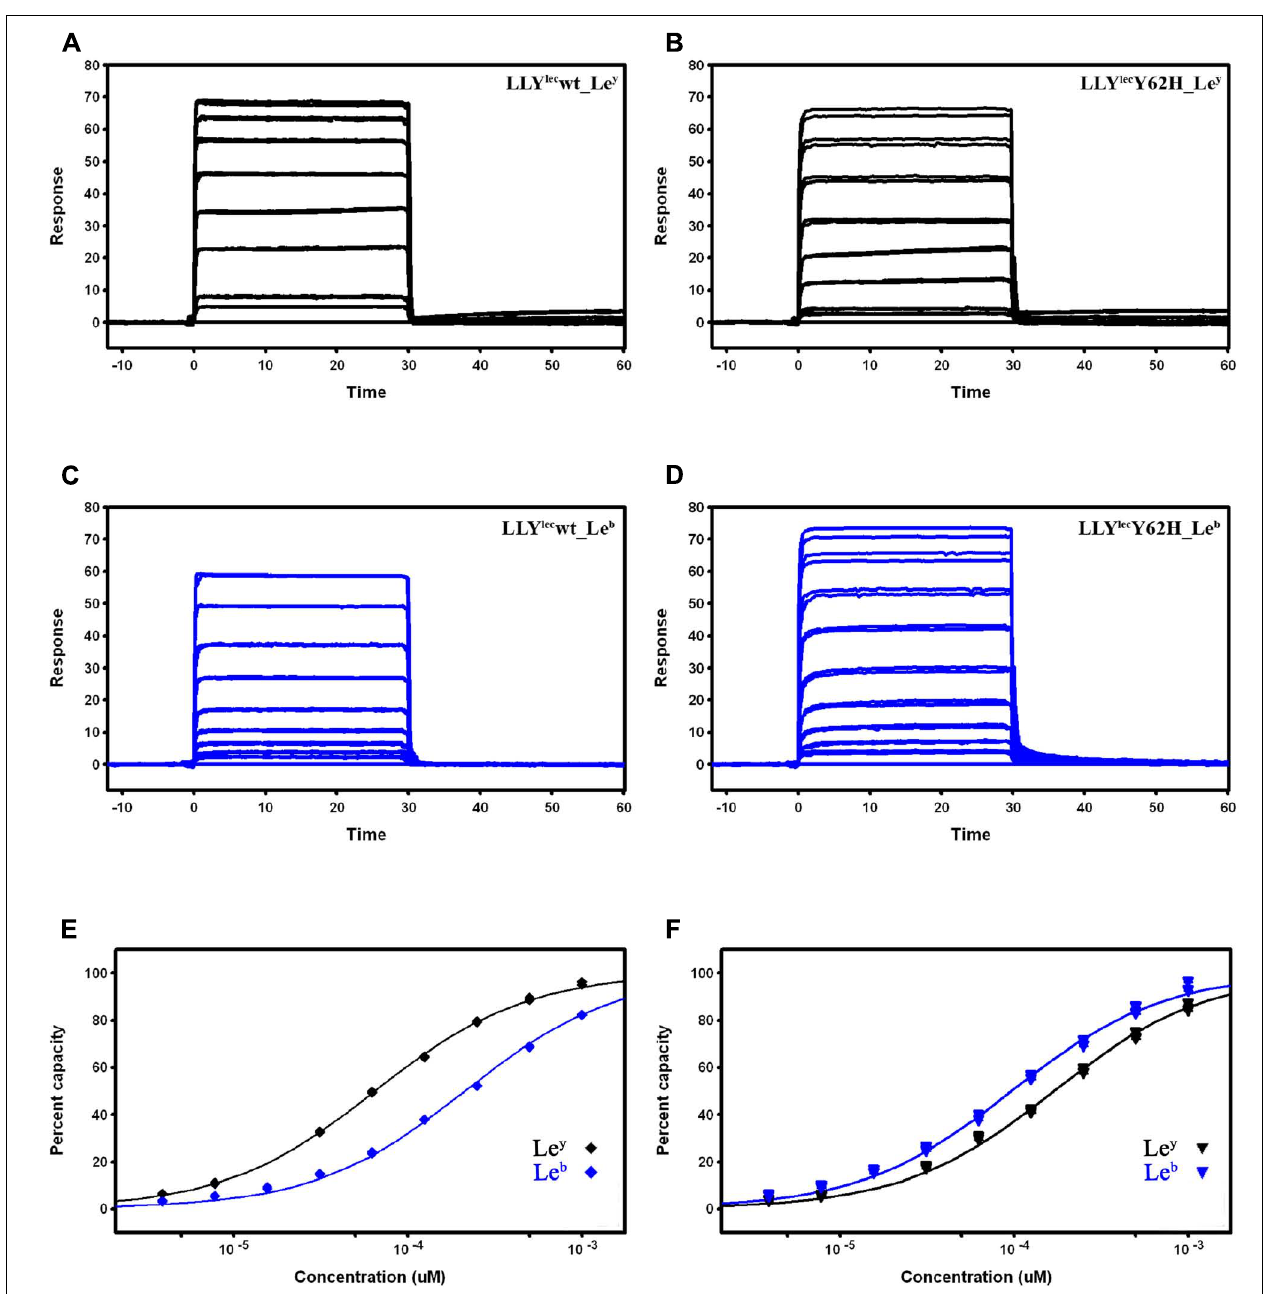
LLY lec Y62H vs Le b . Responses at equilibrium fitted to simple 1:1 binding isotherms for Le y (black lines) and Le b (blue lines) interacting with